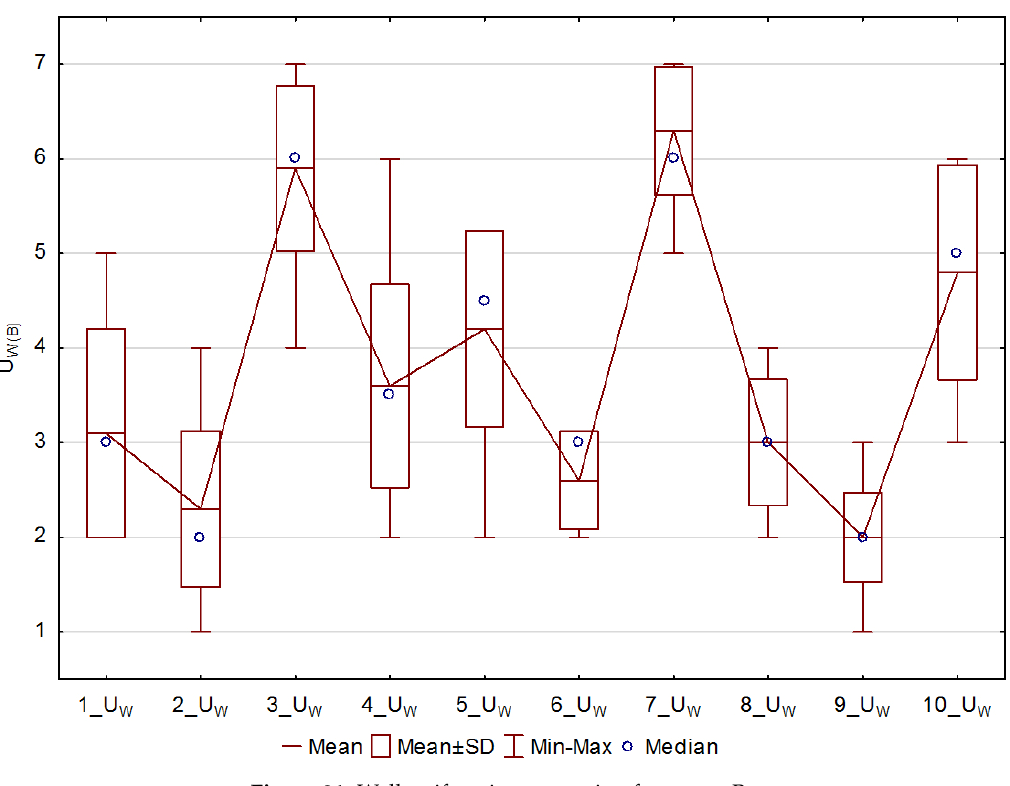
Figure 21. Wall uniformity perception for group B.